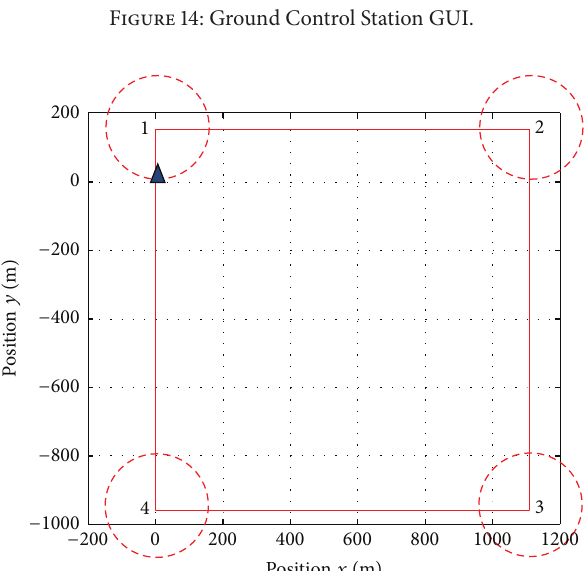
Figure 15: Waypoints and condition goals.